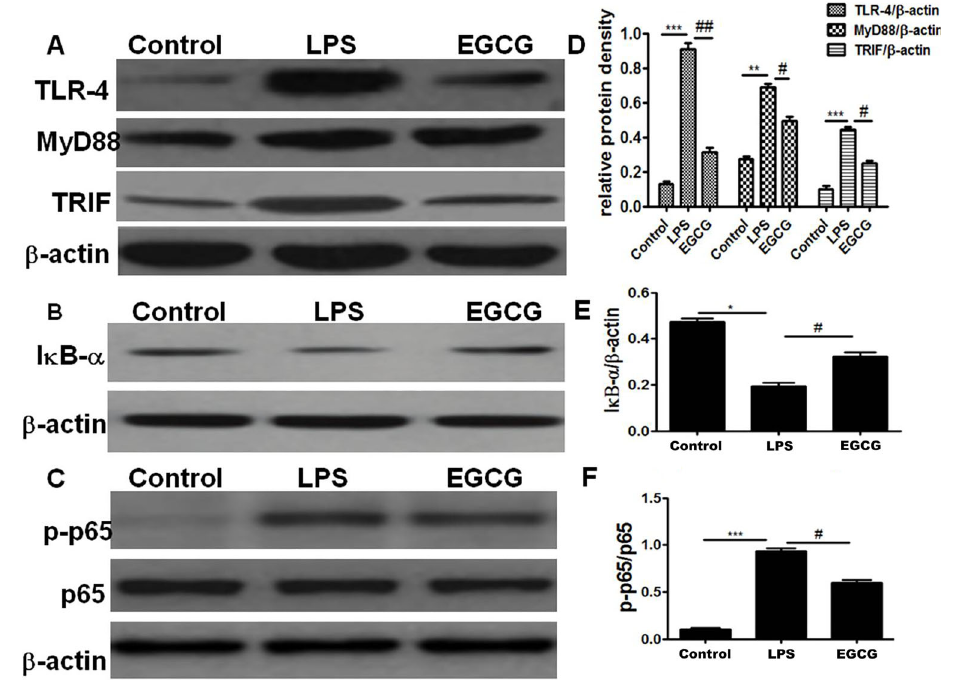
Figure 2. Effect of epigallocatechin-3-gallate (EGCG) pretreatment on TLR-4/NF- k B signaling after acute lung injury induced by lipopolysaccharide (LPS). A to C: Western blot analysis was employed for expression of TLR4, MyD88, TRIF, I k B- a , p-p65, and p65, normalized by b -actin. D to F: Semi-quantitative analysis of 10 animals studied in each group for each protein. Data are reported as means ± SE. ***P o 0.001, **P o 0.01, *P o 0.05 compared to Control; ## P o 0.01, # P o 0.05 compared to LPS